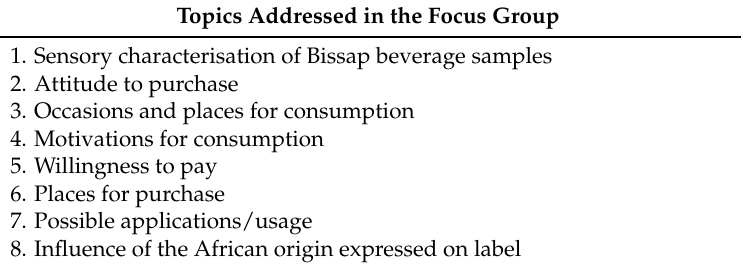
Table 1. Topics addressed in focus group.